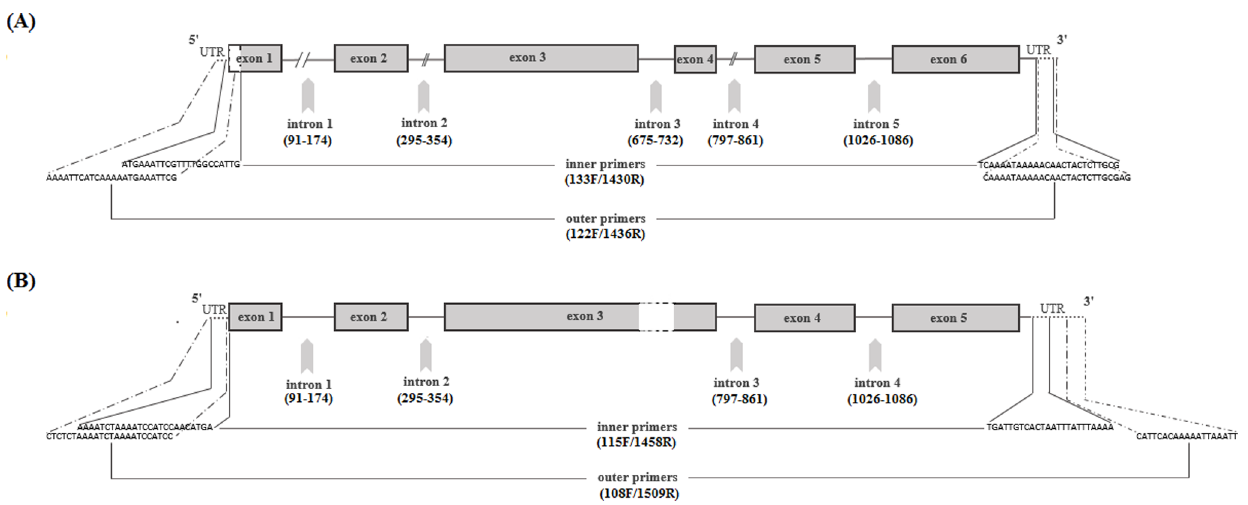
Figure 1. Gene map of Der f 1 (A) and Der p 1 (B) allergens amplified by nested PCR. UTR: untranslated regions; (numbers): nucleotide position for introns. The blank region with dashed outlines at exon 1 indicates partial 5 9 end of genes (given our sequences). T3/SP4 tails (see table 1) in primer sequences are not